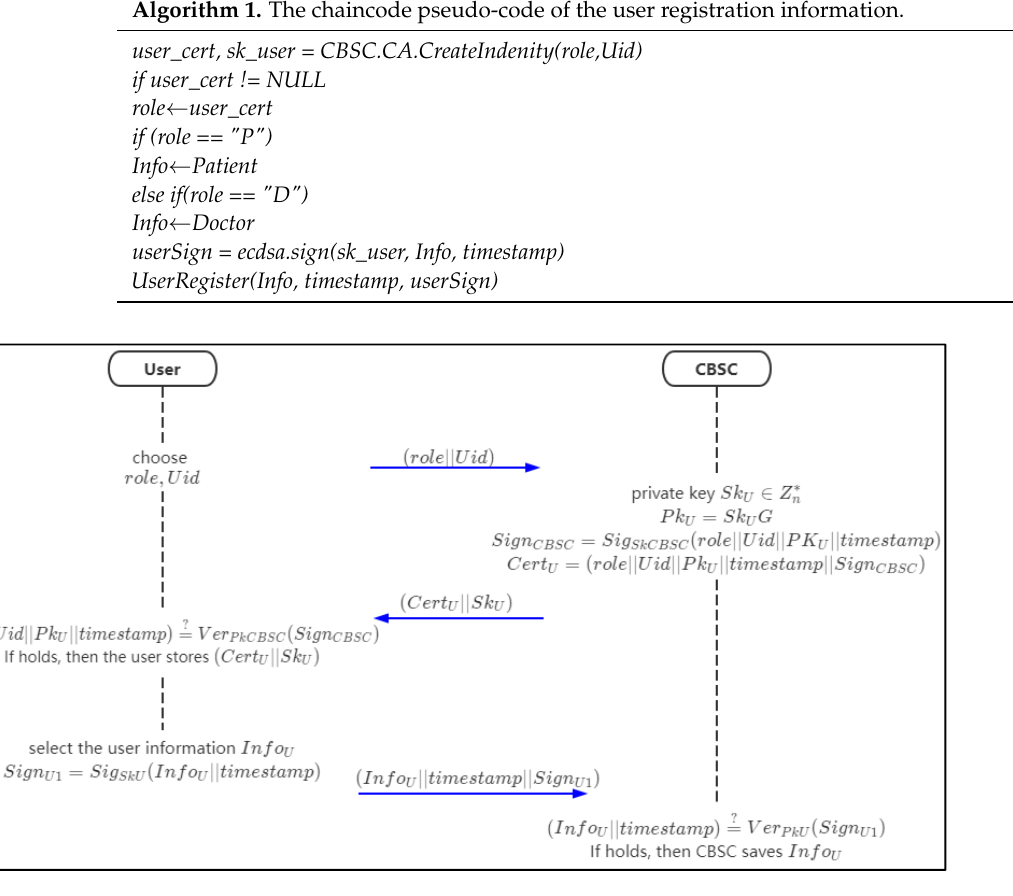
Figure 6. The flow chart of user registration.